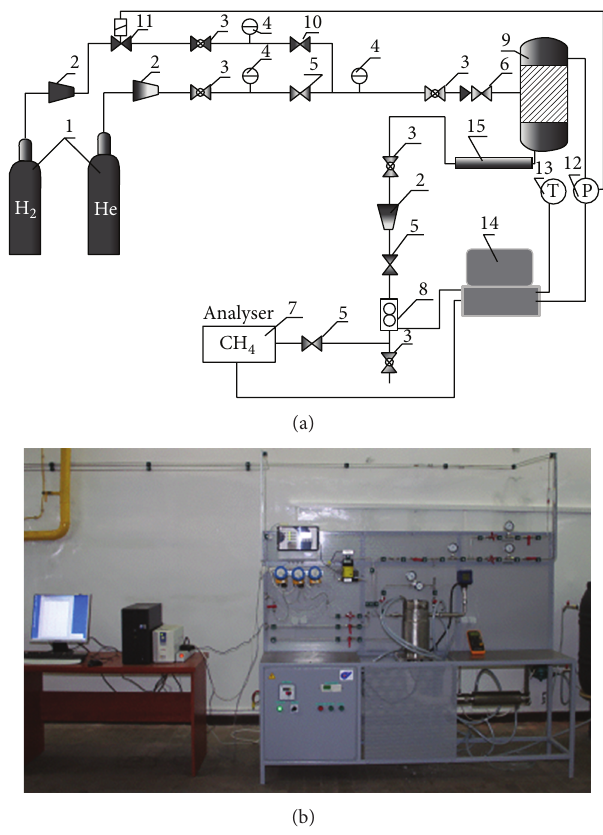
Figure 1: (a) Scheme: 1: gas cylinder, 2: pressure regulator, 3: